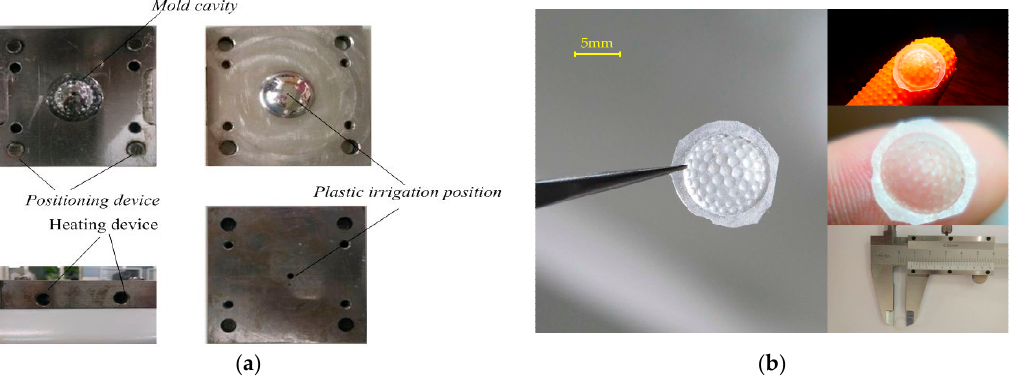
Figure 7. Preparation of curved compound eyes: ( a ) curved compound eye mold; ( b ) the finished product.